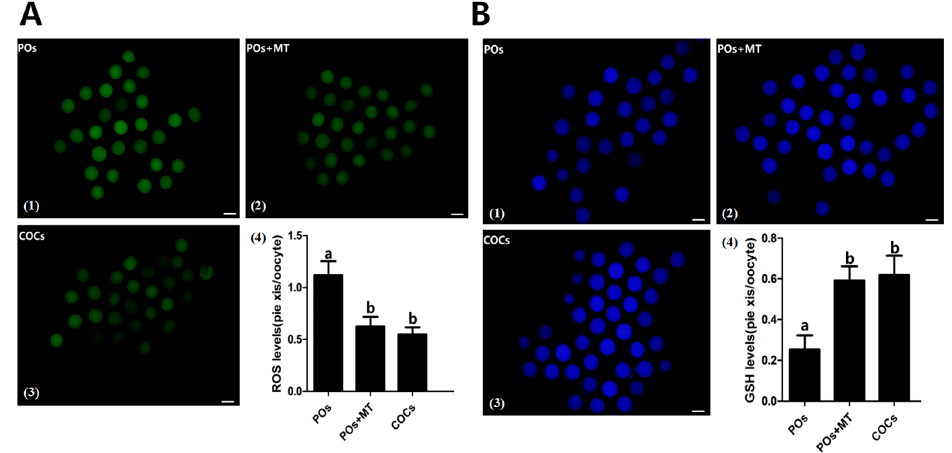
Figure 2. Effects of melatonin on ROS as well as GSH levels in bovine IOs. ( A ) Effects of melatonin on levels of ROS in IOs; A(1–3) the representative images of the H2DCFDA fluorescence staining. The higher green intensity indicated more ROS; scale bar = 100 μ m; A(4): the statistical analysis of the data from A(1–3); n = 4; ( B ) Effects of melatonin on levels of GSH in IOs, B(1–3) the representative images of the GSH fluorescence staining. The higher the blue intensity is the more the GSH; scale bar = 100 μ m; B(4) the statistical analysis of the data from B(1–3); n = 4. (a,b) Values of different superscripts indicate significant difference ( p < 0.05).